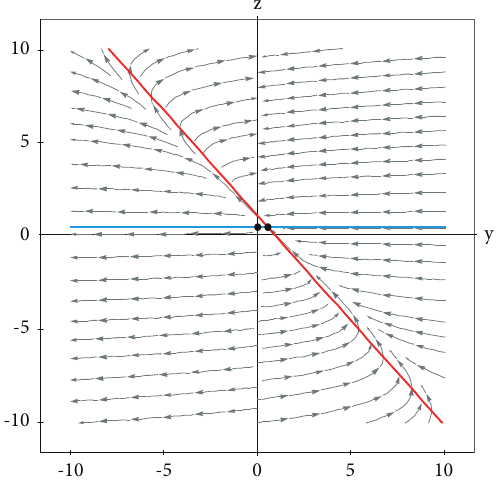
Figure 12: Phase plane of system (9) for 1/ σ < R <∞ , with 0 R ≃ 8 . 772 ( β ′ � 1 . 5 ) ; the other rates are δ � 0 . 071, α � 0 . 1, and 0 σ � 0 . 17. The vector field and some trajectories are indicated by lines and arrows in gray. Two nullclines are shown: one horizontal (blue line) and other vertical (red line); the horizontal and vertical remaining pair coincides with the z -axis. The disease-free equi- librium point E ≃ ( 0 , 0 . 4581 ) is unstable, and the endemic 0 E ∗ ≃ ( 0 . 5419 , 0 . 4581 ) is a stable node of two “straight-line” solu- tions; both points are indicated by a black